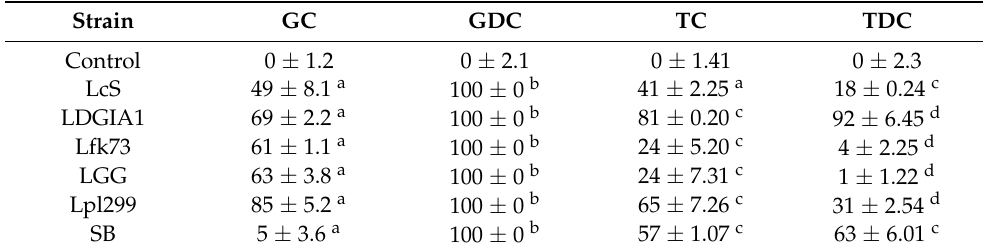
Table 3. Bile salt deconjugation activity (%) of the six strains of probiotics evaluated by HPTLC. Strain